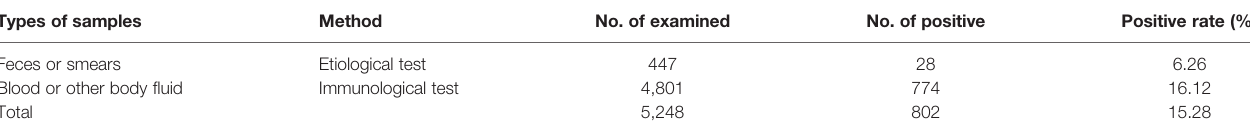
TABLE 1 | The results of all samples tested.